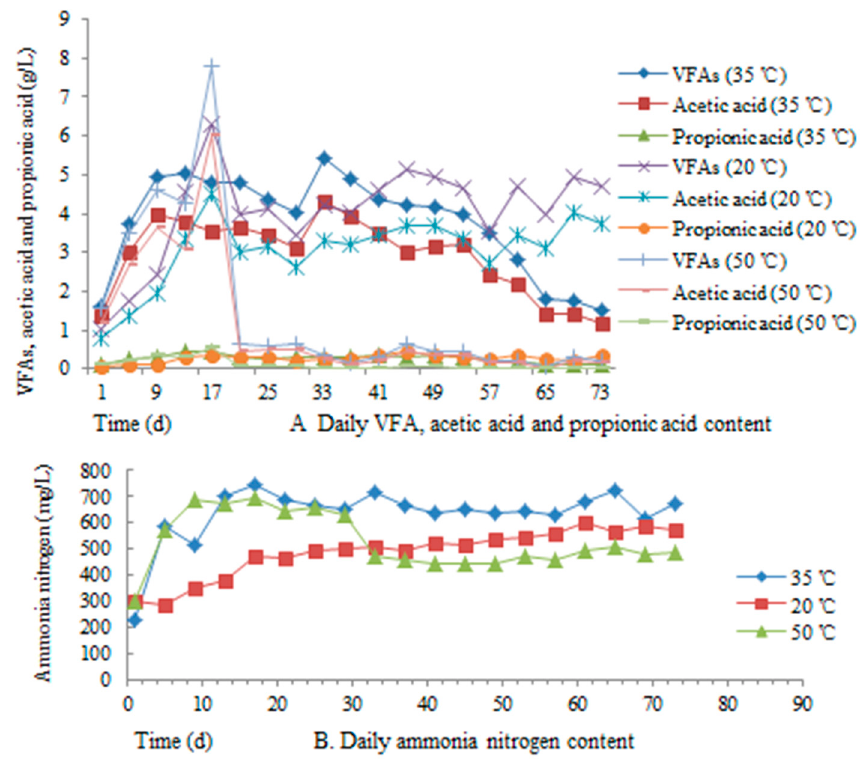
Figure 5. The change in the volatile fatty acids (VFA) and ammonia nitrogen content at different